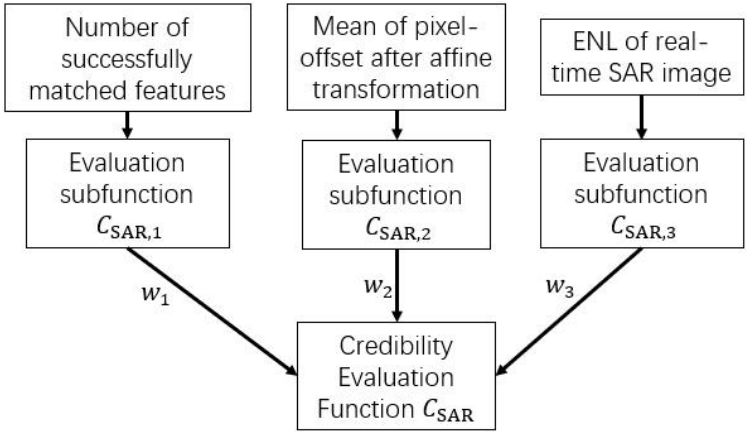
Figure 2. SAR credibility